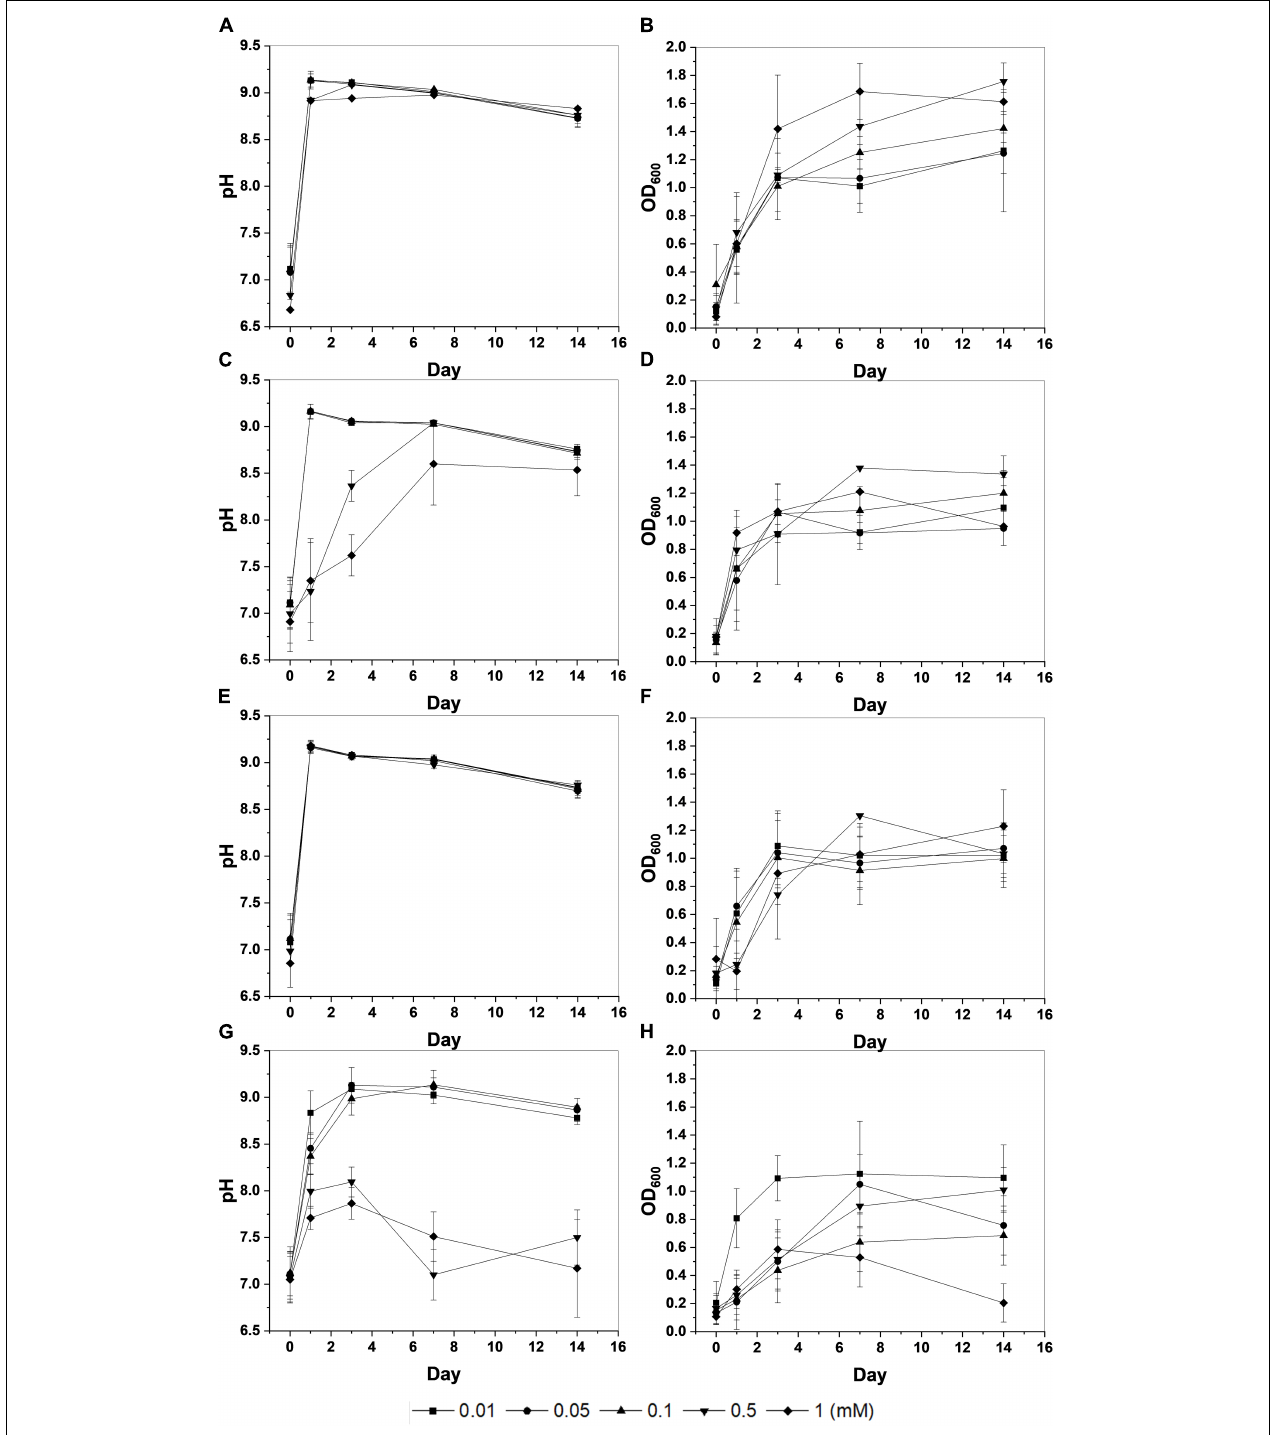
FIGURE 1 | Changes in pH and optical density (OD 600 ) of KCTC 3558 culture at various metal concentrations (mM): Cu (A,B) ; Zn (C,D) ; Pb (E,F) ; and Cd (G,H) .